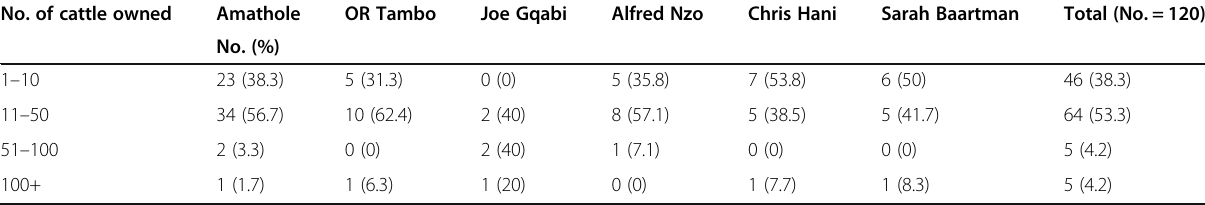
Table 4 Cattle herd size owned by the Nguni Cattle Project beneficiaries across six districts No. of cattle